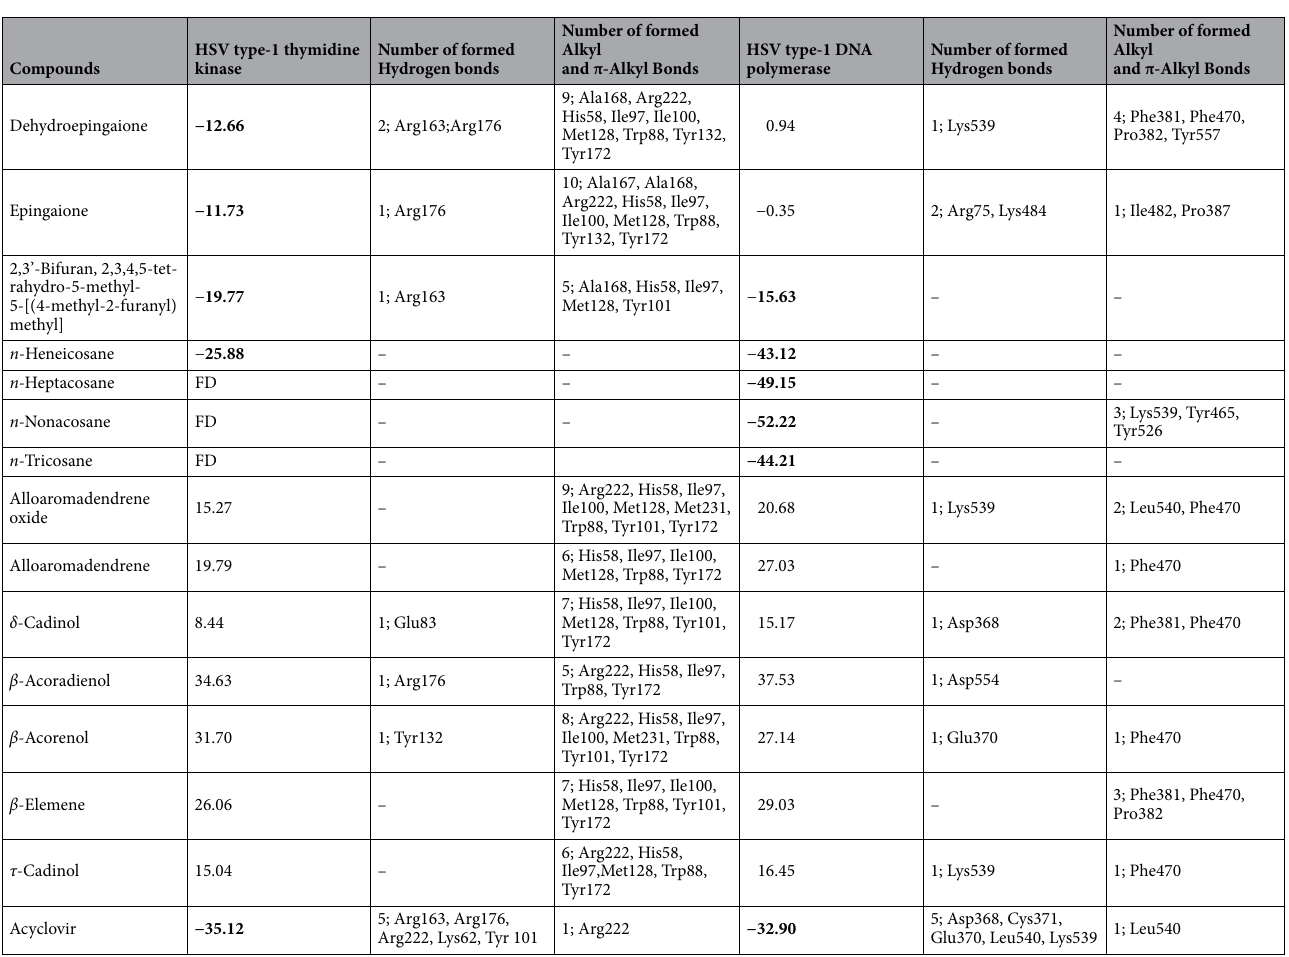
Table 3. Binding energies (kcal/mol) of the major identified compounds from different organs of B. daphnoides in HSV type-1 thymidine kinase and HSV type-1 DNA polymerase active sites using molecular modelling experiment. Significant values are